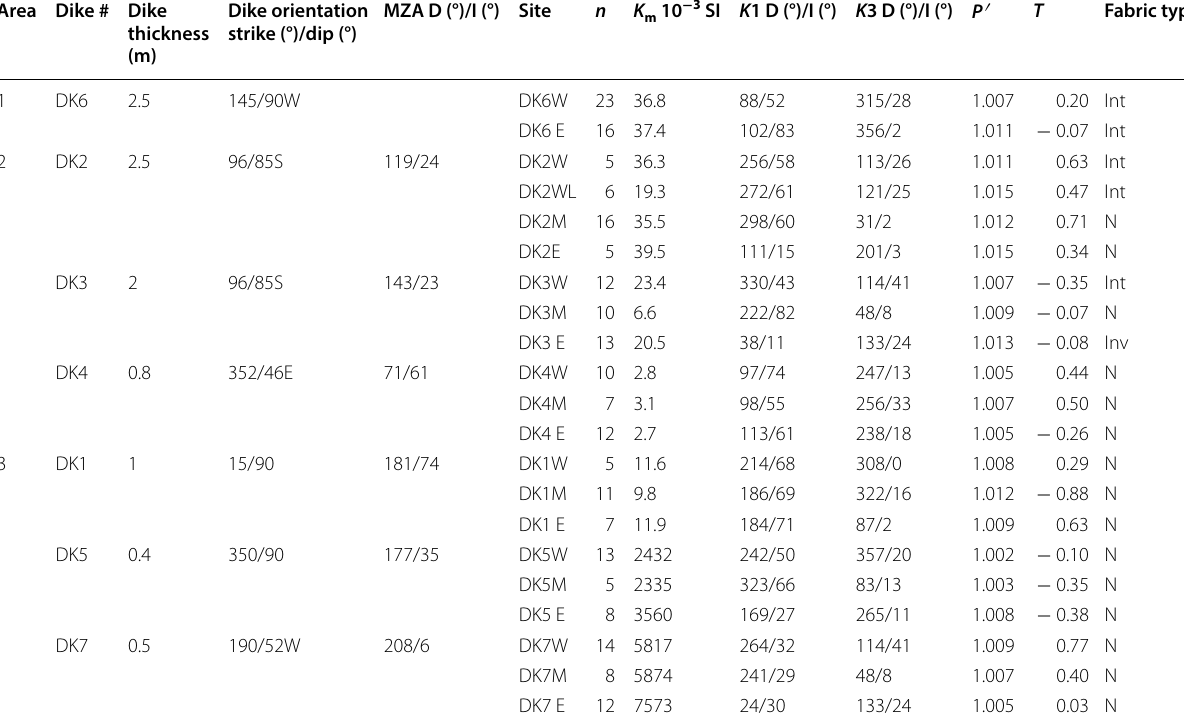
Table 1 Geometry of the dikes and mean AMS